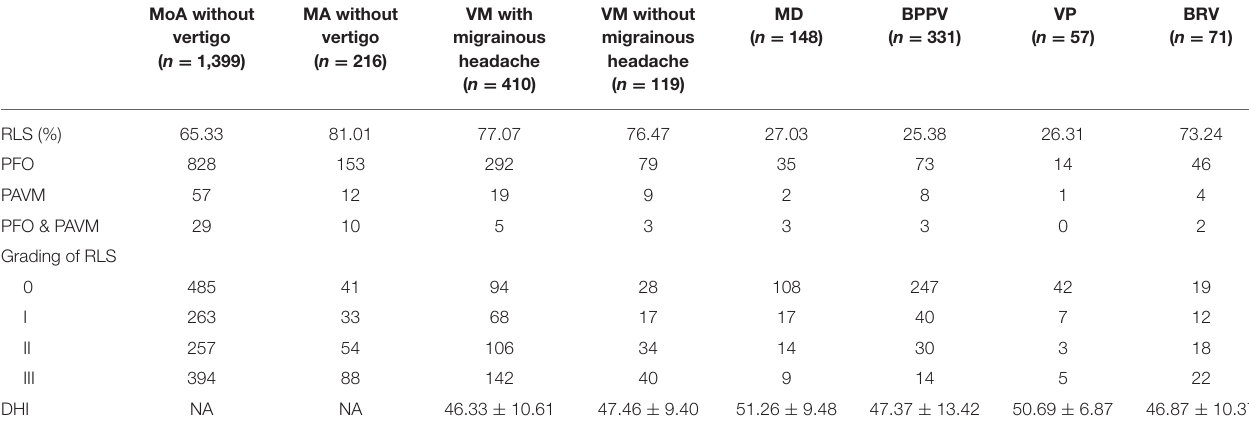
TABLE 3 | Right-to-left shunt and Dizziness Handicap Inventory in patients from different groups.